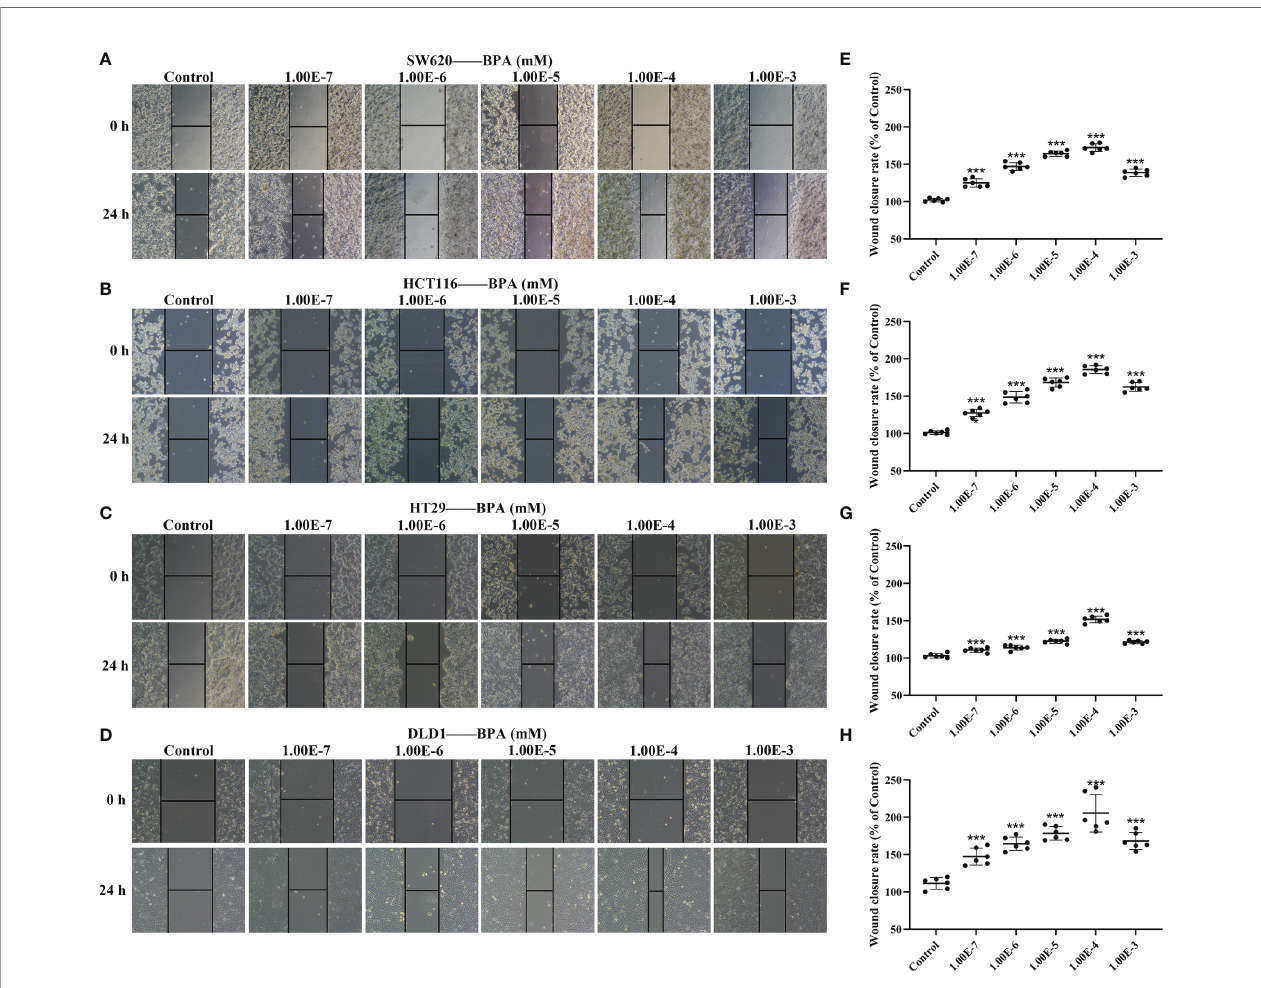
FIGURE 2 | The comparison of BPA exposure on the migration ability of different colon cancer cells. Representative images of cell migration of SW620 (A) , HCT116 (B) , HT29 (C) and DLD1 (D) cells under different concentrations of BPA. Quantitative analysis of wound closure rate corresponding to cell migration of SW620 (E) , HCT116 (F) , HT29 (G) and DLD1 (H) cells exposed to BPA, n = 6. Values are expressed as means ± SD, compared with the control group, *** p <